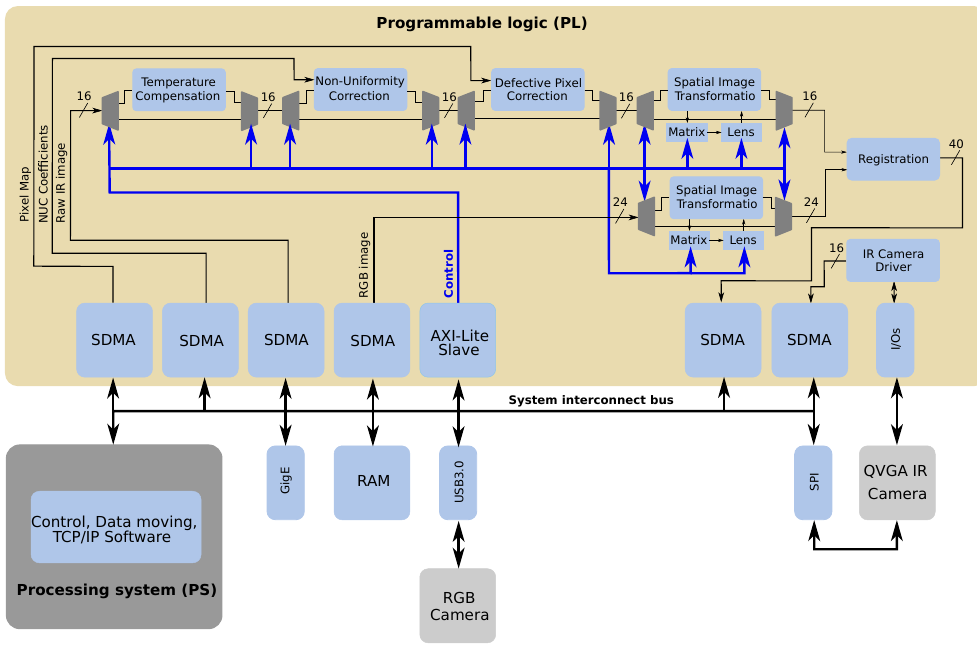
Figure 2. Overall system